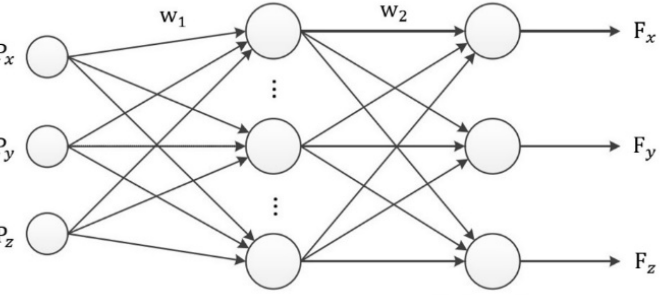
Figure 7. Structure of BP neural network with three-dimensional force decoupling.